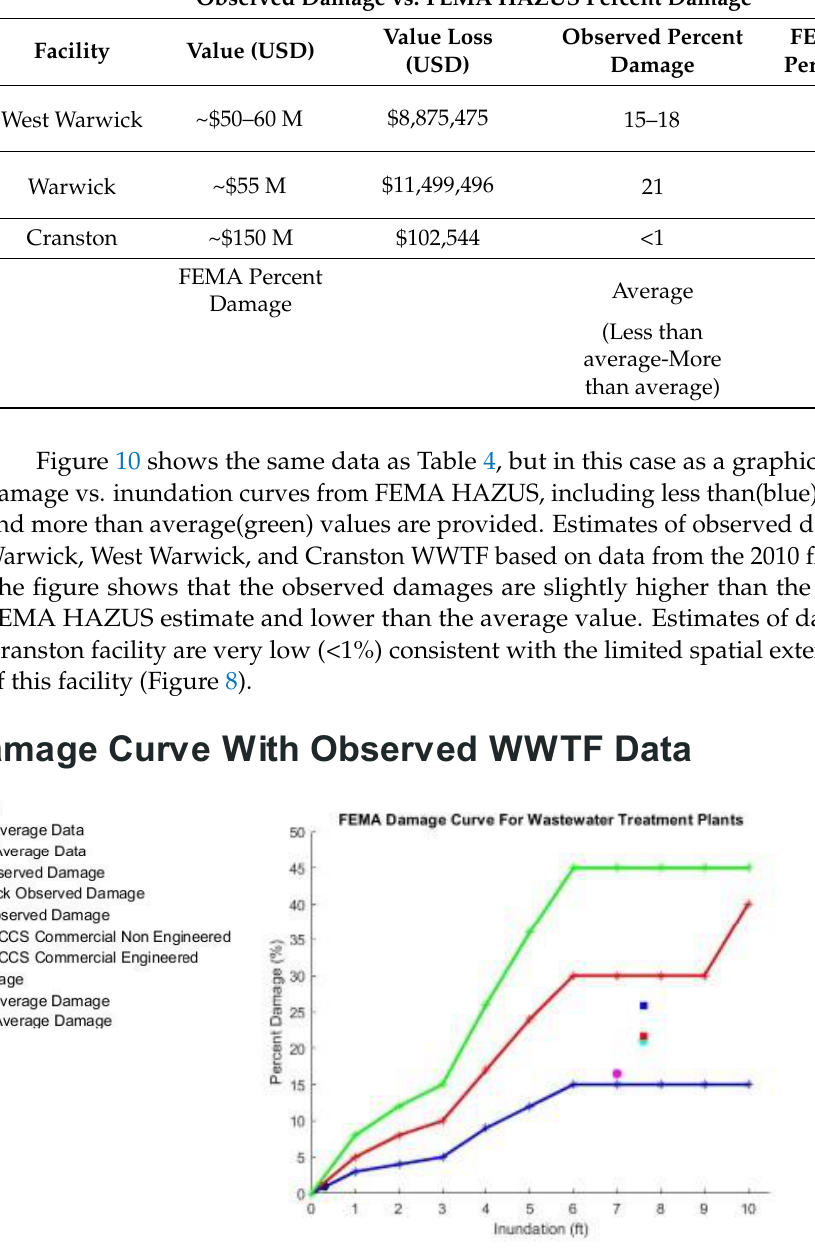
Figure 10. Percent damage vs. inundation curves from FEMA HAZUS, including less than aver- age(blue), average(red), and more than average(green) values. Estimates of observed damage for the Warwick, West Warwick, and Cranston WWTF are also shown. Damages to the Warwick